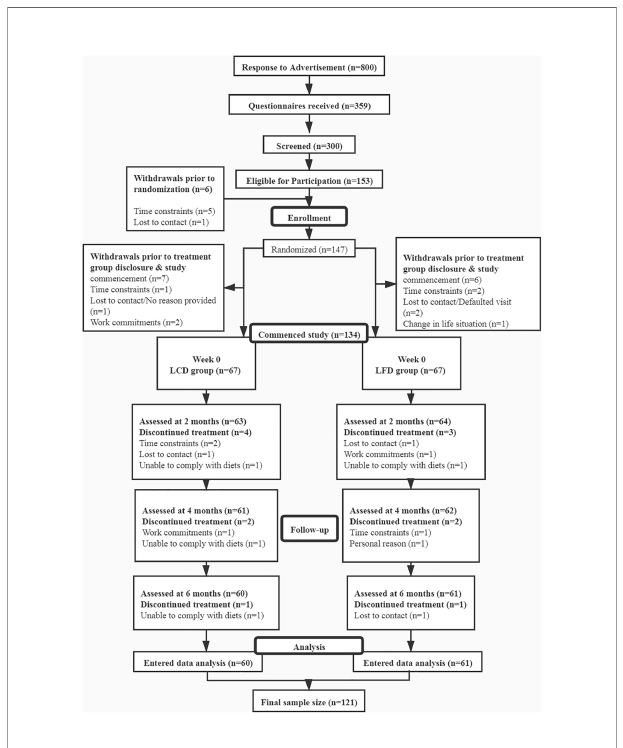
FIGURE 1 | Study fl ow